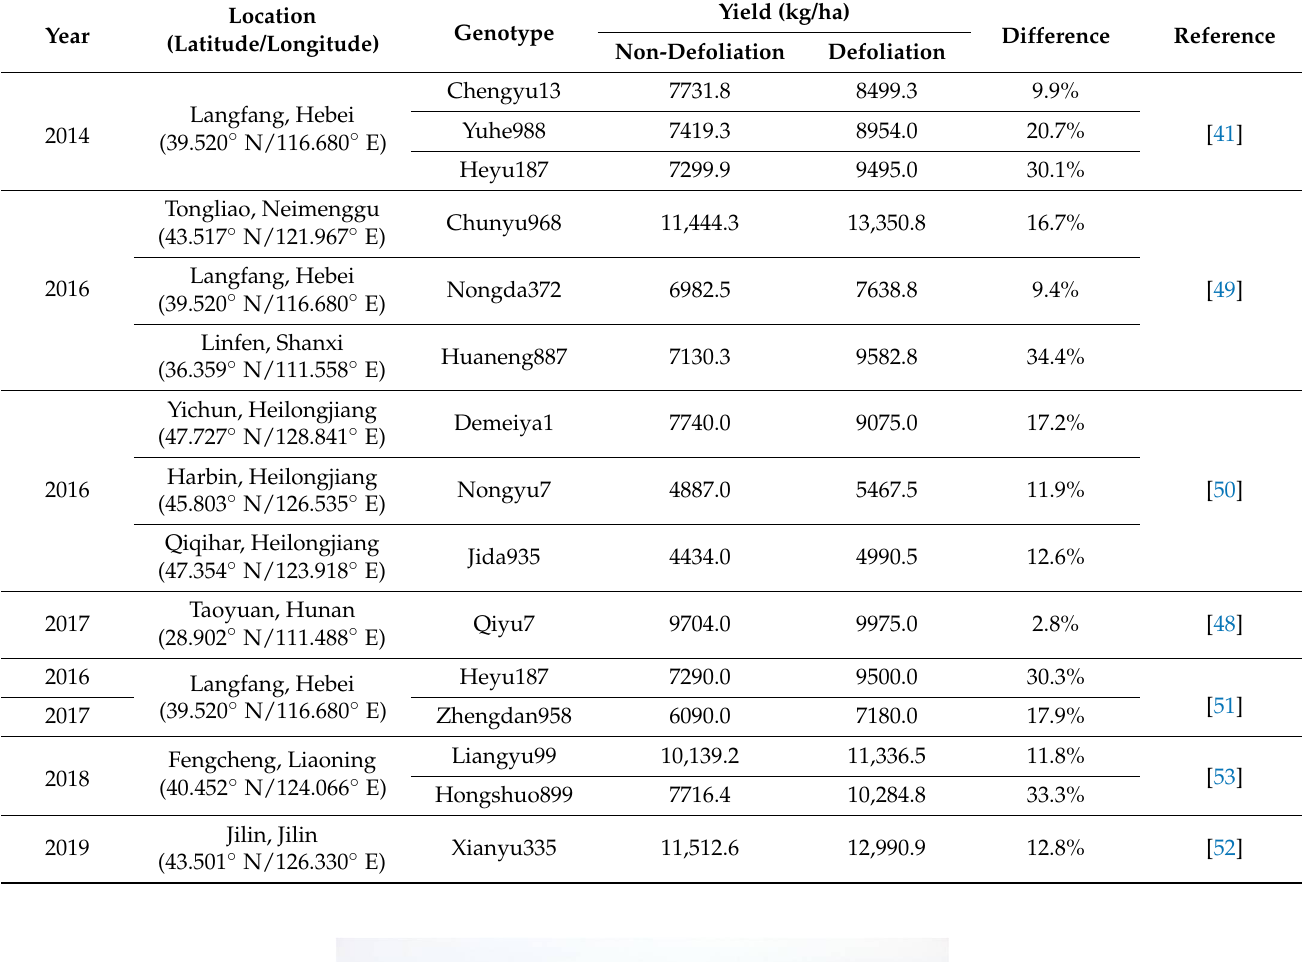
Table 2. Changes in grain yield of maize following defoliation at D5 in Northern China.